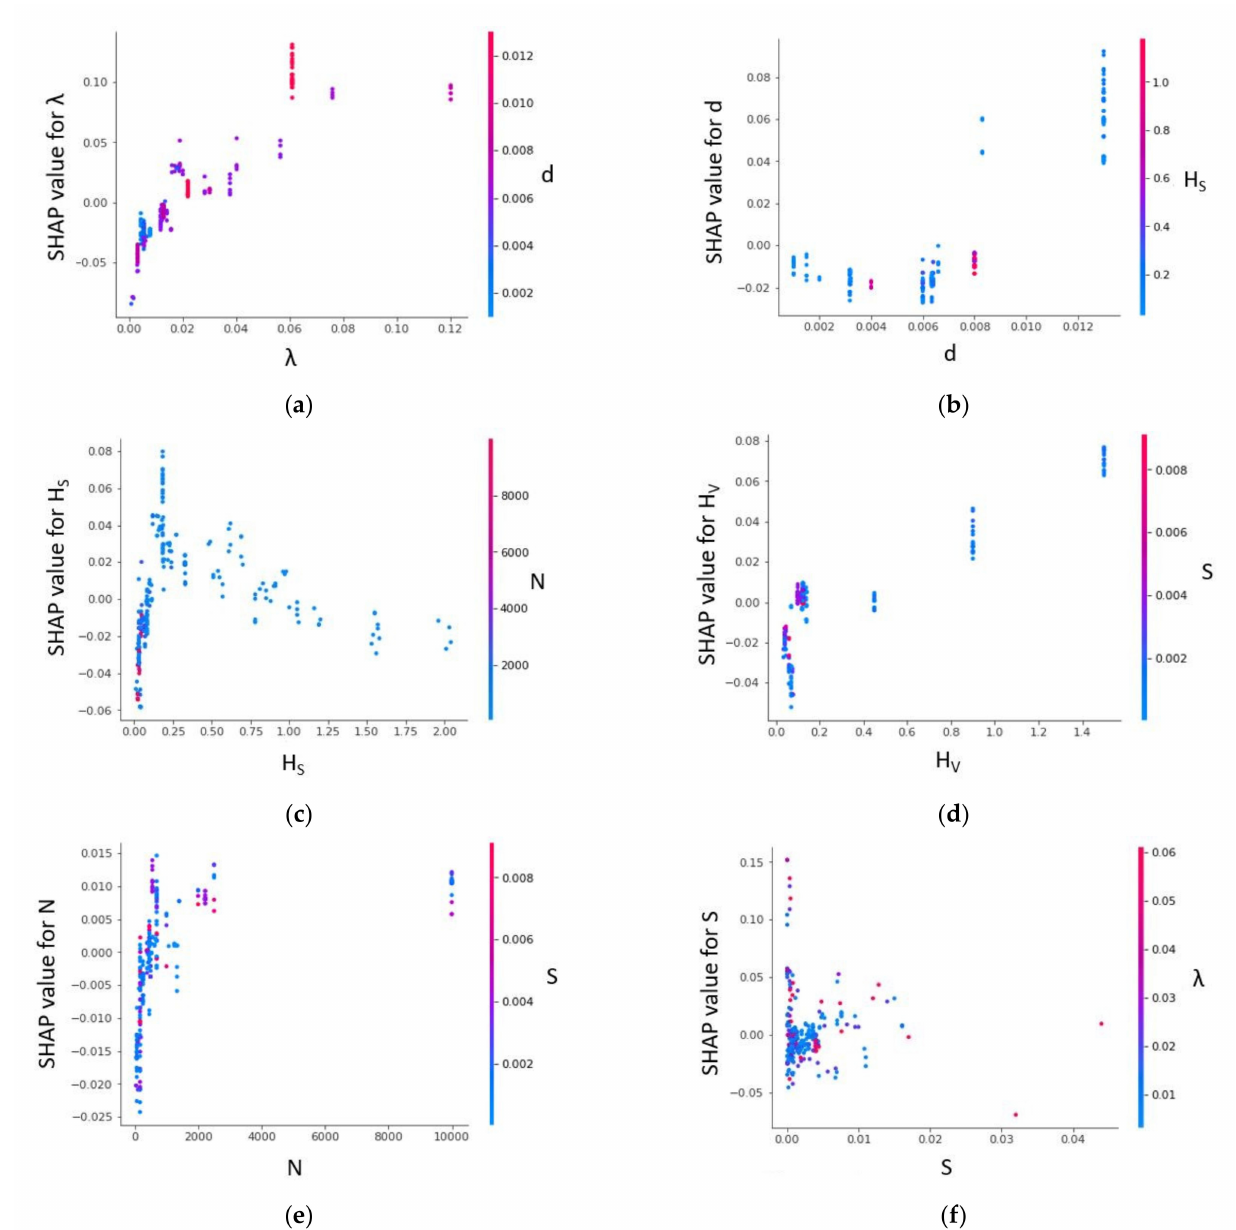
Figure 19. SHAP dependence plot for XGBoost model (f S